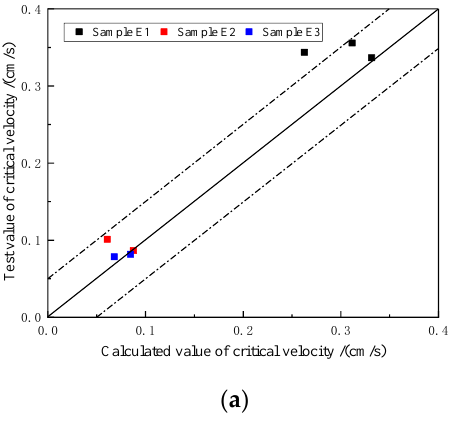
Figure 7. Comparison of predicted and test values of critical velocity: ( a ) horizontal seepage and ( b ) vertical